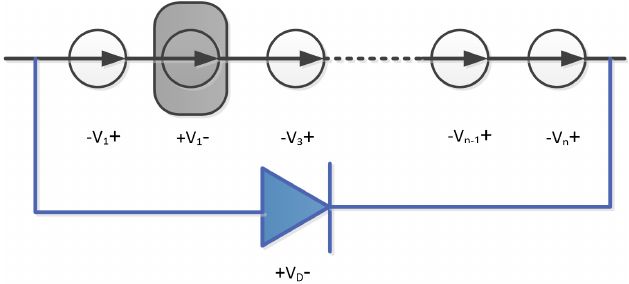
Figure 4. Bypass diode parallel with PV cells.